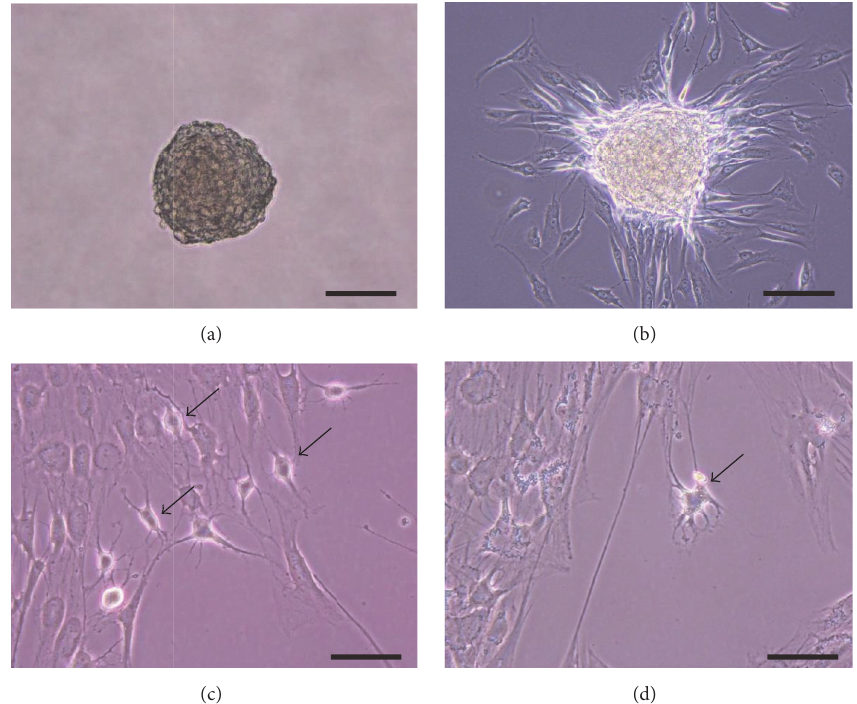
Figure 4: Neurosphere generation of hDFCs. (a) A floating cell sphere of hDFCs cultured in serum-free medium with FGF, EGF, and B27 supplement for 3 days. (b) The cells spread out from the neurosphere that adhered to the fibronectin-coated dish on day 0 of culture in NDM. (c) The cells extended from the neurosphere on day 3 of culture in NDM. (d) The cells extended from the neurosphere on day 7 of culture in NDM. Scale bars (a, b) = 100 𝜇 m and (c, d) = 50 𝜇 m. Arrows indicate neural-like cells with branched dendrites and refractile cell